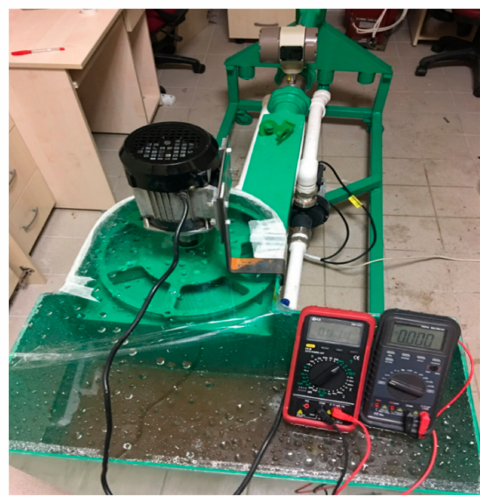
Figure 2. Experimental setup of vertical hydrokinetic turbine.